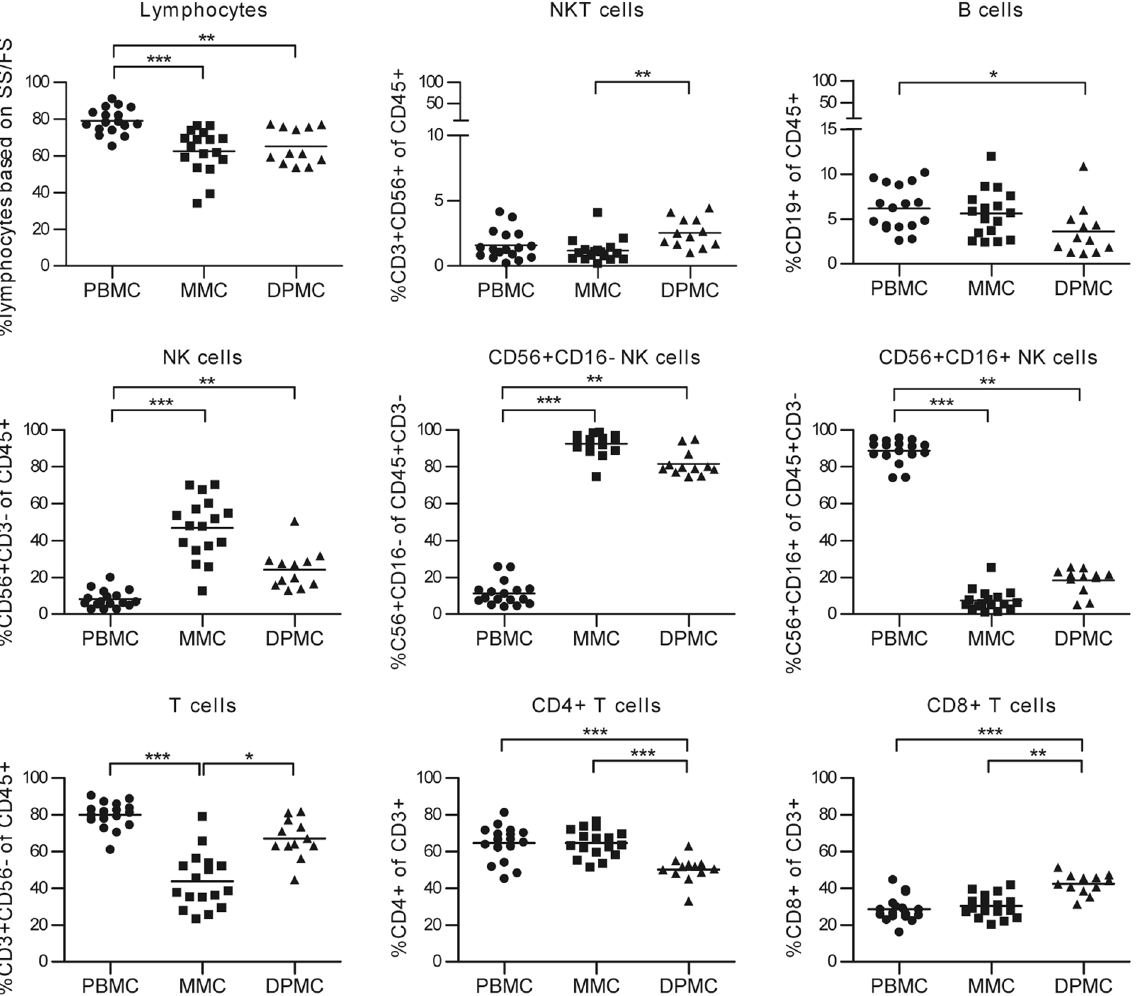
Figure 1. Lymphocyte composition of peripheral blood, menstrual blood, and term decidua. Mononuclear cells were isolated from peripheral blood (PBMC, n = 17), menstrual blood (MMC, n = 17), and decidua parietalis (DPMC, n = 12). Percentages of lymphocytes (CD45 + ) based on side scatter (SS) and forward scatter (FS), T cells (CD56 − CD3 + ; CD4 + and CD8 + ), NKT cells (CD3 + CD56 + ), NK cells (CD3 − CD56 + ; CD56 + CD16 + and CD56 + CD16 − ), and B cells (CD19 + ) were obtained by flow cytometric analysis. * P < 0.05, ** P < 0.01, and *** P < 0.001 (lines indicate mean, non-parametric Kruskal-Wallis with Dunns post-hoc